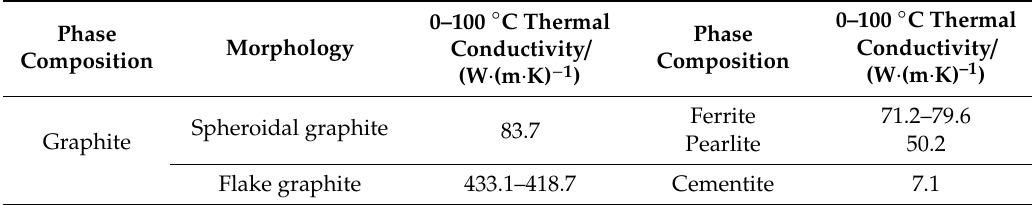
Table 3. Thermal conductivity of constituent phases of cast